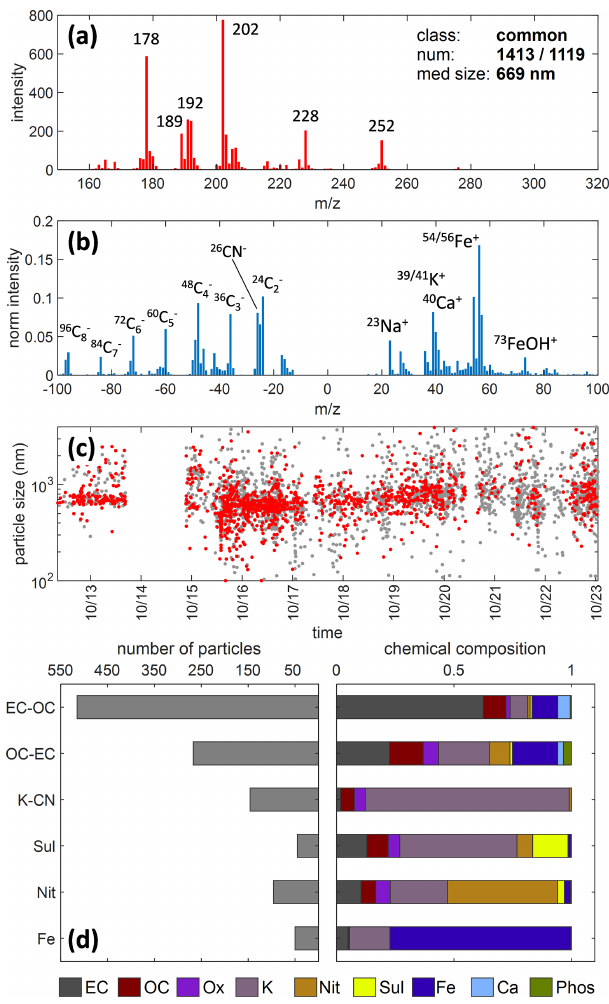
Figure 6. PAH patterns up to high molecular weights are associated with strong K + signals and the absence of Fe + , giving evidence for biomass-burning particles. (For figure explanation, see Fig.